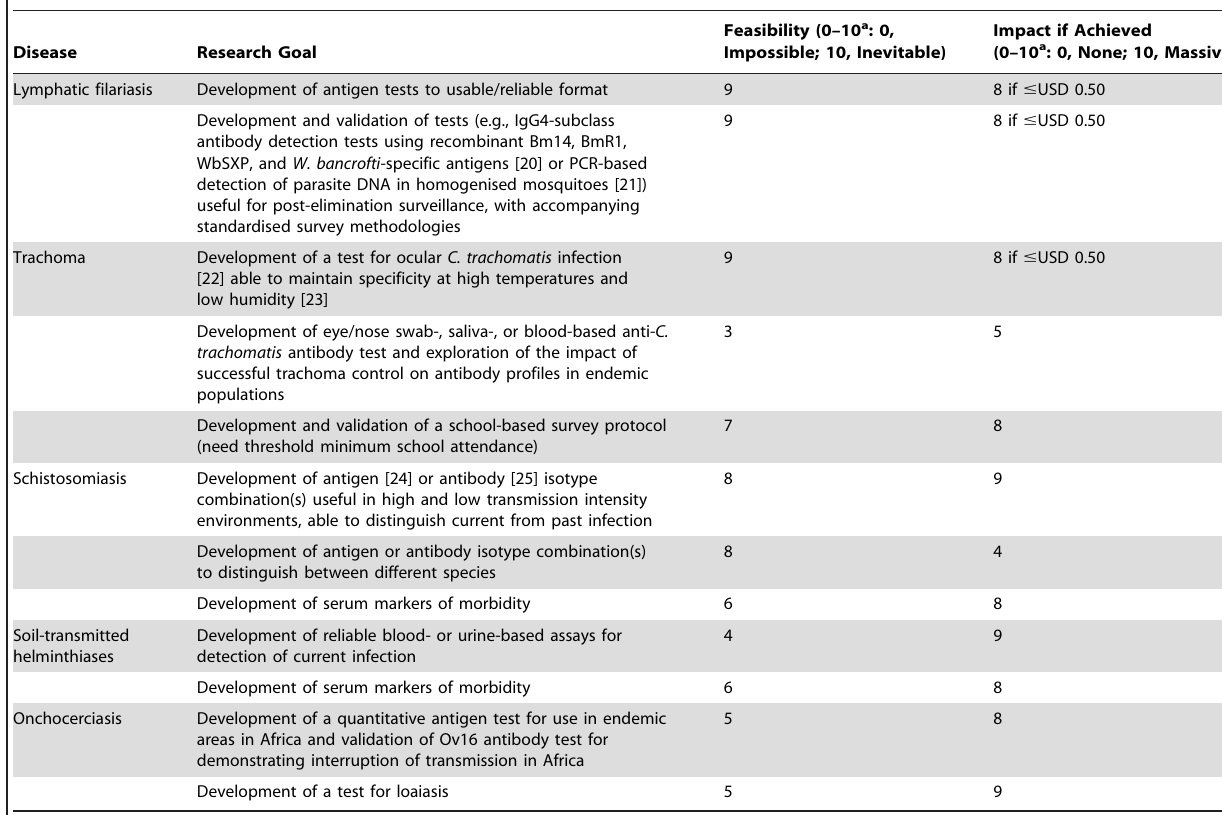
Table 3. Immediate research priorities.